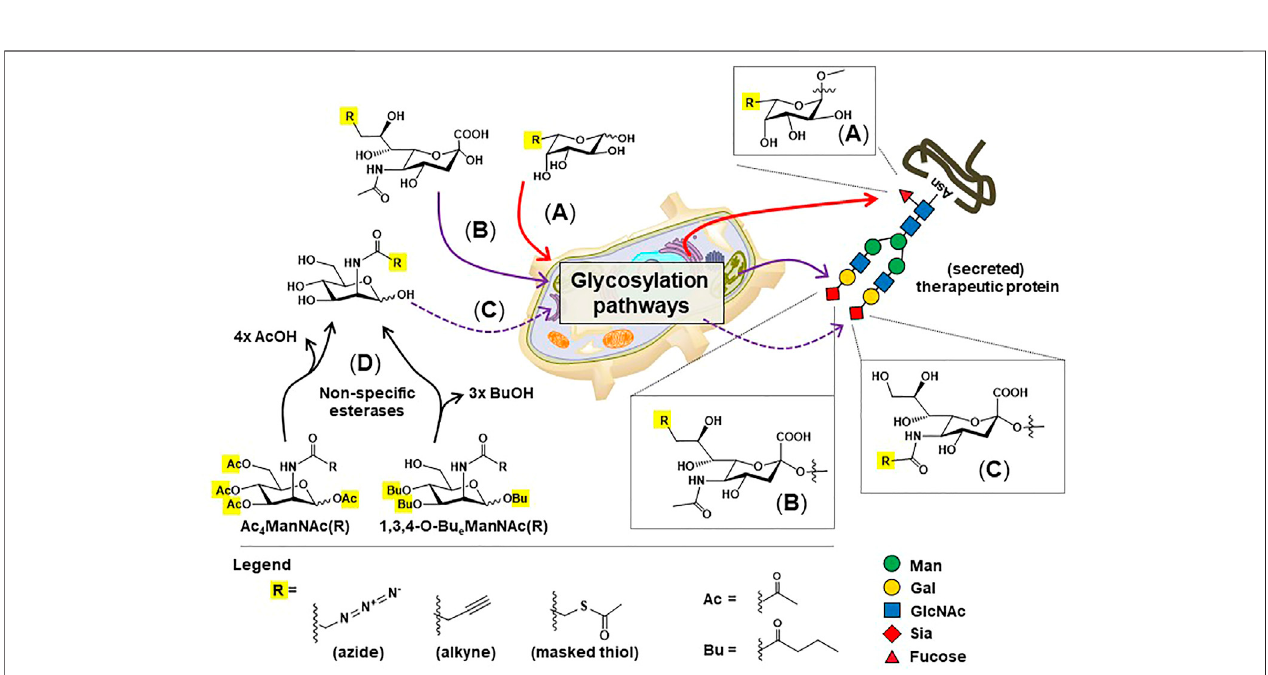
FIGURE 6 | Overview of metabolic glycoengineering (MGE). Non-natural monosaccharide analogs capable of installing “ chemical handles ” into the N-glycans of therapeutic proteins include: (A) C6-modi fi ed fucose (B) C9-modi fi ed sialic acids, and (C) C2-modi fi ed ManNAc analogs, which are converted to N-acyl (C5) modi fi ed sialic acidsbefore installation into N-glycans. (D) “ High- fl ux ” esterase-protected ManNAc analogs are now widely employed in MGE experiments to increase cell uptake and reducethe concentrations required for media supplementation from 30 to 75 mM (Yarema et al., 1998) to 100 μ M or less (Jones et al., 2004; Kim et al., 2004; Almaraz et al.,